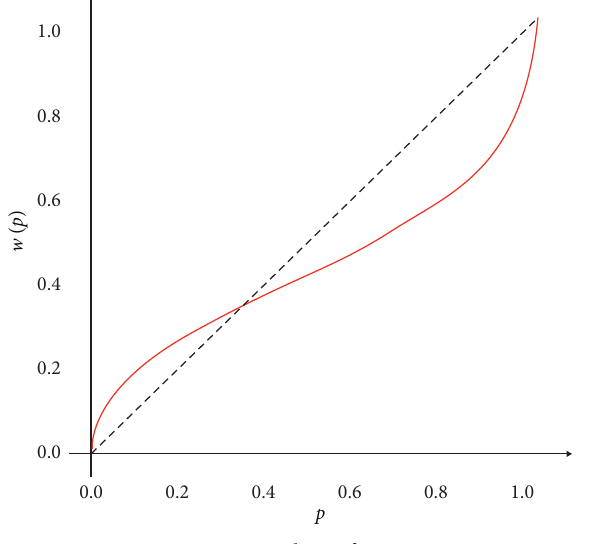
Figure 4: Weighting function.